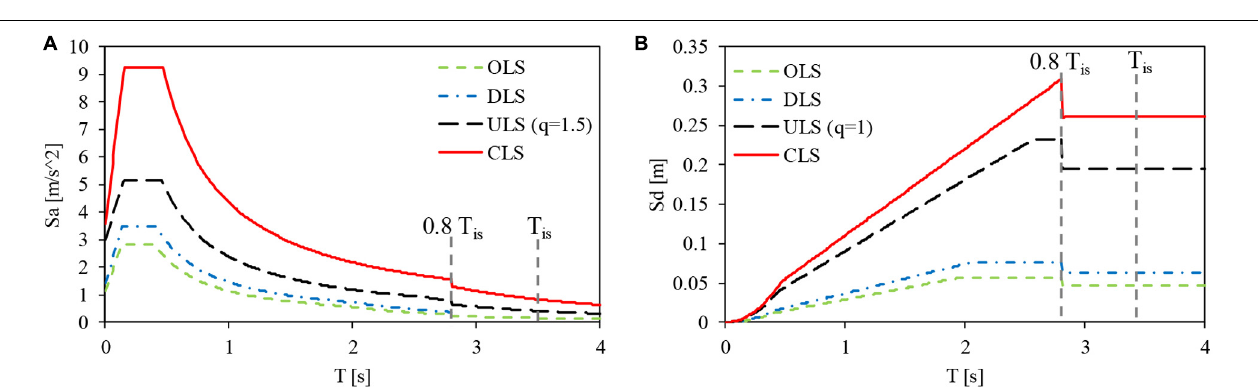
FIGURE 3 | Capitals for the isolation system devices (HDR bearings and flat sliders).